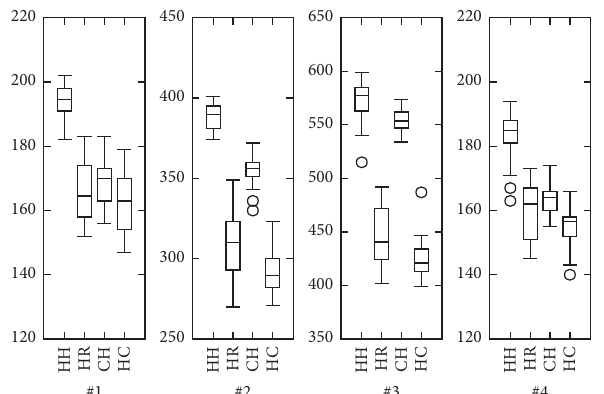
Figure 6: Boxplots of lengths of schedules (minimum, lower quartile, median, upper quartile, maximum, and outliers) returned by the LS algorithms for the benchmark given in [7, 8] with cov � 80%.